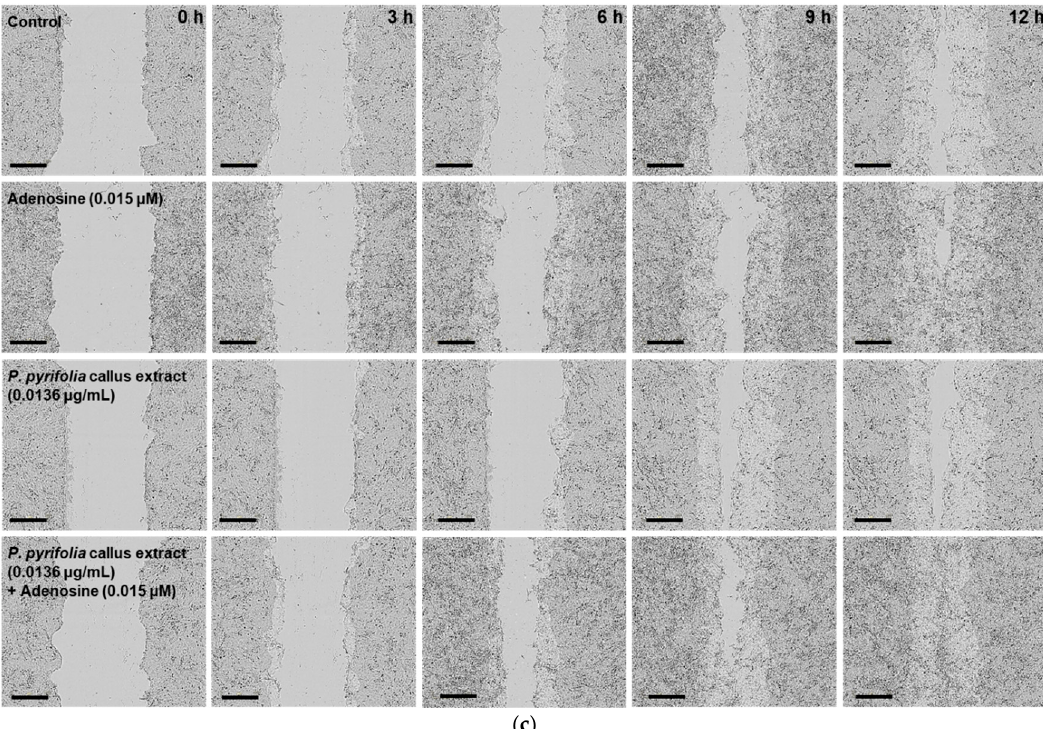
Figure 6. Relative scratch wound recovery of HaCaT cells after incubation with adenosine and P. pyrifolia callus extract. ( a ) Relative scratch wound recovery of HaCaT cells after 9 h. ( b ) Time course of relative scratch wound recovery area of HaCaT cells. ( c ) Representative microscopic images of scratch wounds after cells were treated with serum-free medium (control), adenosine (0.015 µM), and P. pyrifolia callus extract (0.0136 µg/mL) alone or in combination with adenosine (0.015 µM). Values are means ± standard deviation ( n = 6). * p < 0.05, *** p < 0.001 compared to untreated control. # p < 0.05, ### p < 0.001 compared to adenosine alone (0.015 µM). $$$ p < 0.001 compared to P. pyrifolia